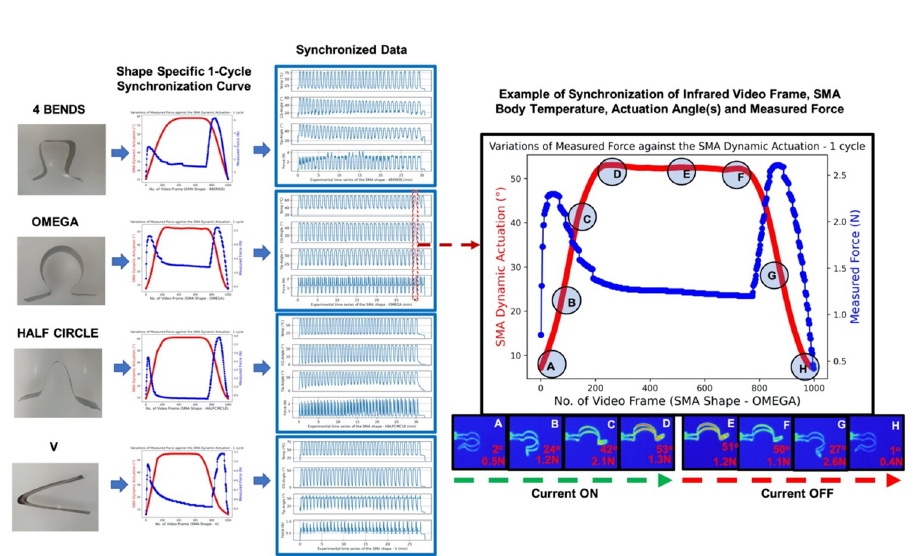
Fig 4. This figure shows the data synchronization procedure. The force, angles, temperature time series and selected video frames were synchronized against time stamps. It also shows an example of utilization of the 1-cycle synchronization curve for a larger data